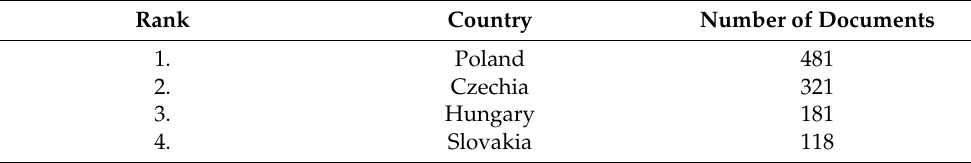
Table 3. The rank of V4 countries in dealing with the topic of Smart cities. Rank Country Number of Documents